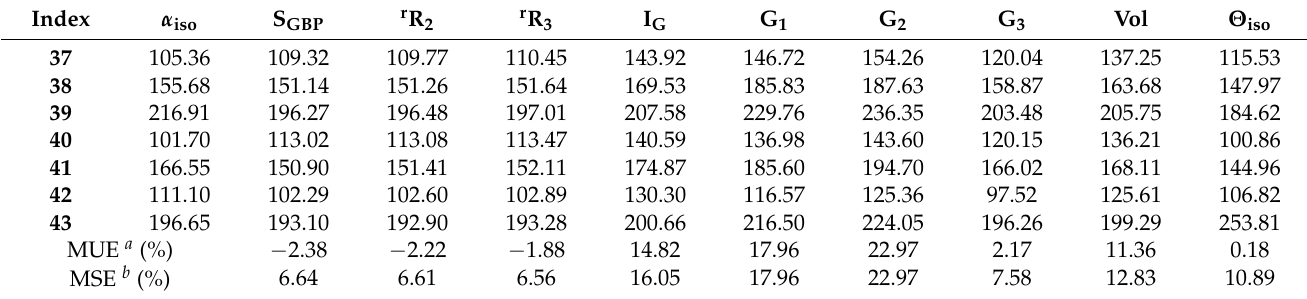
Table 5. Comparison of molecular polarizabilities ( α iso , in Bohr 3 /mol) at S 0 predicted with the linear regression equations in Table S1 with conventional data as a reference for all the systems in Scheme 3.